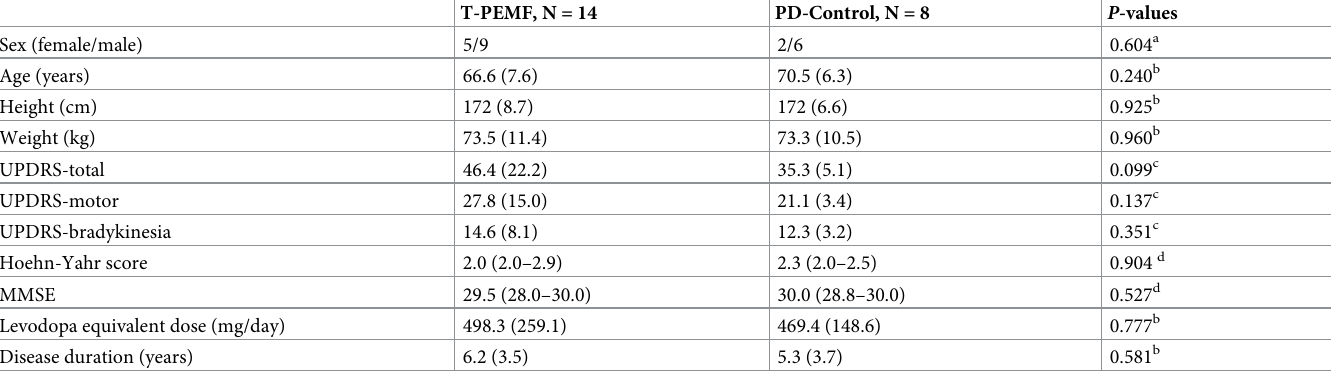
Table 1. Characteristics of the participants with Parkinson’s disease (PD) in the T-PEMF intervention group and the PD-control group. T-PEMF, N = 14 PD-Control, N = 8 P